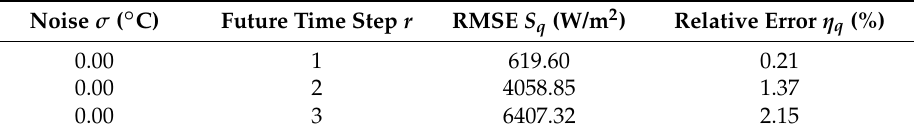
Table 2. Error analysis for heat flux inversion when no measurement noise is